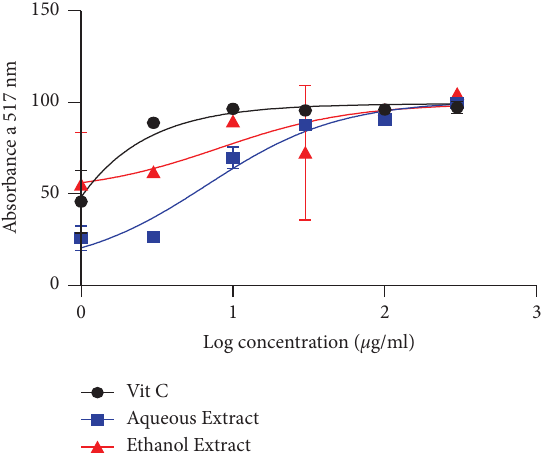
Figure 2: DPPH radical scavenging activity.